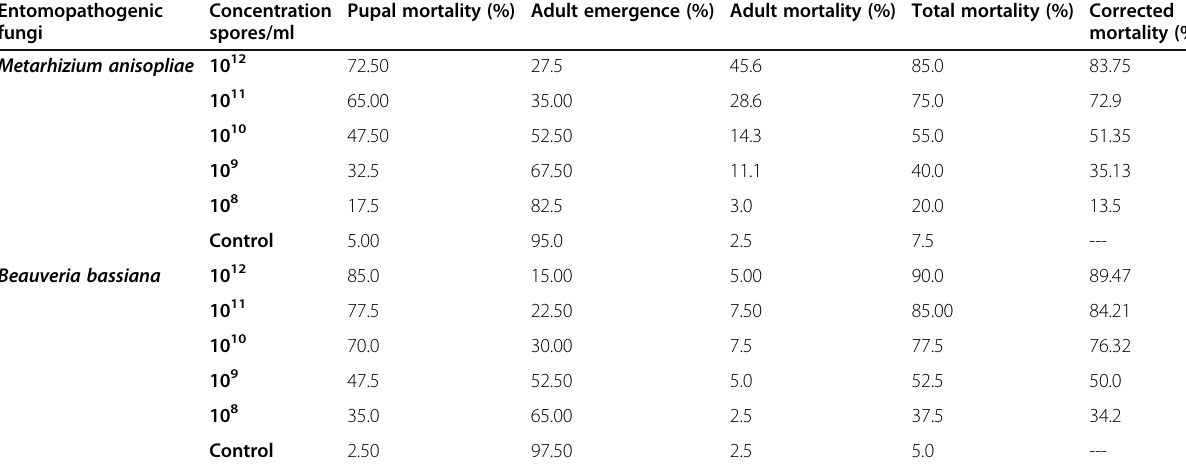
Table 4 Effect of the fungal isolates against pupal stage of Pectinophora gossypiella Entomopathogenic Concentration fungi